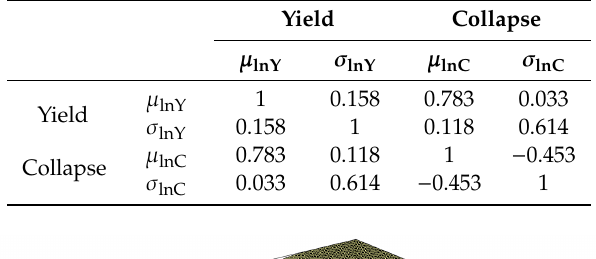
Table 2. Correlation matrix for parameters of RC fragility curves.